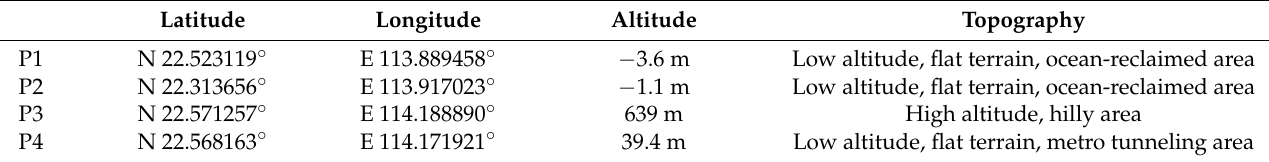
Figure 4. Location of selected points marked by the green star in all sub-figures. ( a ) “P1” in the Qianhai sub-area on a typical ocean reclaimed land; ( b ) “P2” in Hong Kong International Airport (HKIA), an airport built on an ocean reclaimed area; ( c ) “P3” in Wutong Mountain at an altitude over 600 m; ( d ) “P4” in the Liantang sub-area affected by tunneling works of metro construction. Table 3. Details of the four representative persistent scatter (PS) points.